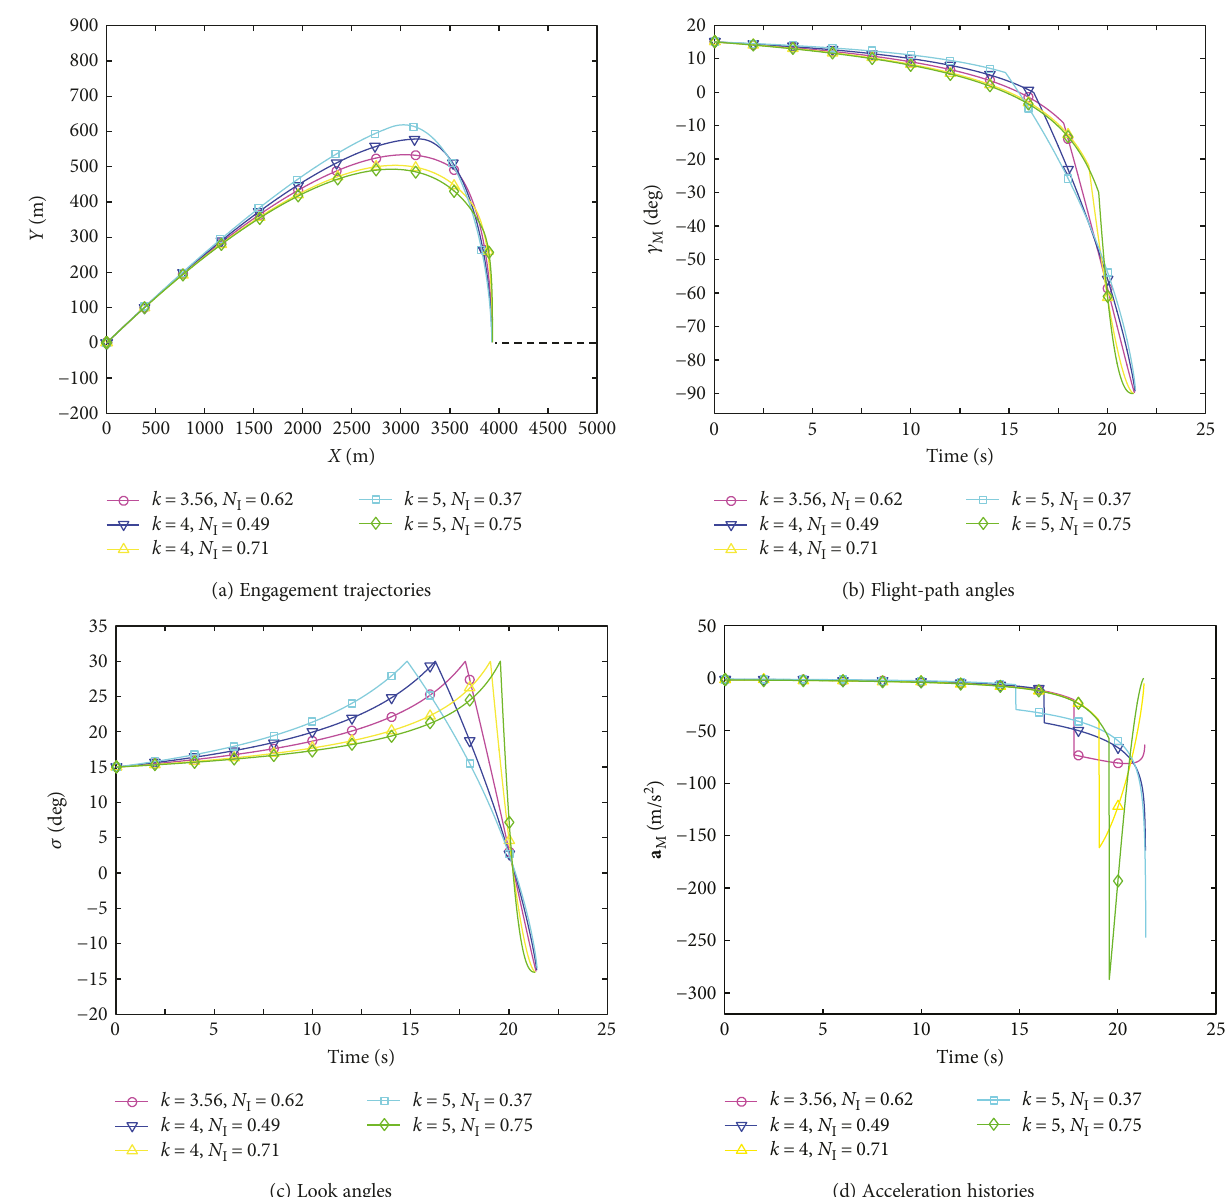
Figure 4: The results for the di ff erent choice of N